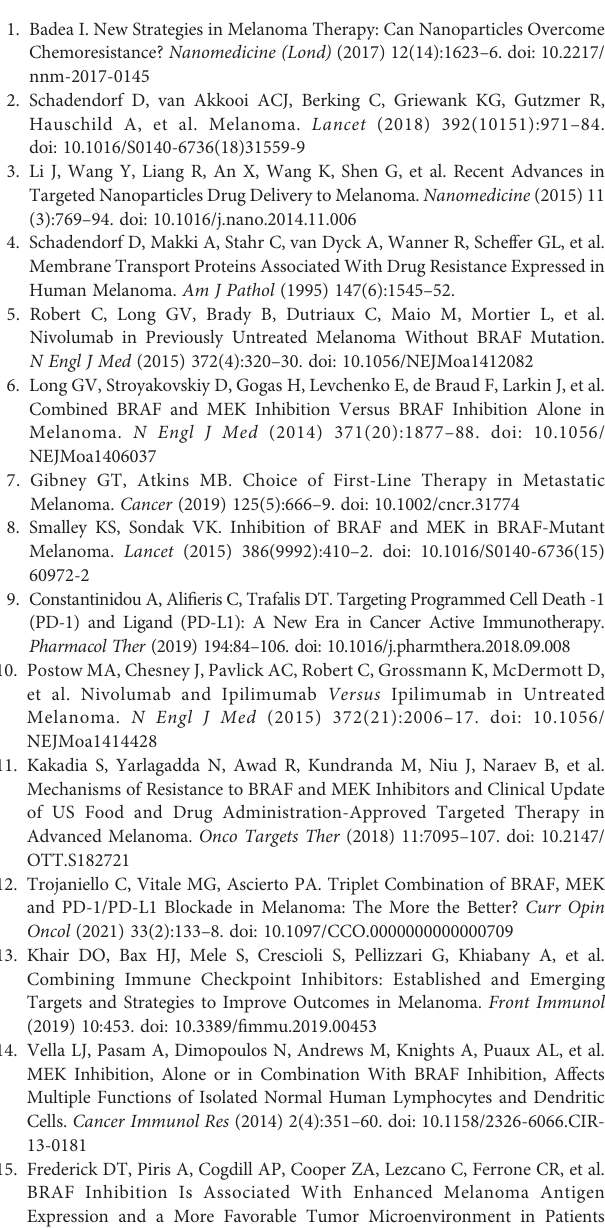
Supplementary Figure 2 | Sensitivity analysis of overall survival (OS). Supplementary Figure 3 | Sensitivity analysis of overall response rate (ORR) Supplementary Figure 4 | Sensitivity analysis of complete response (CR). Supplementary Figure 5 | Sensitivity analysis of partial response (PR). Supplementary Figure 6 | Sensitivity analysis of adverse events for all grades. Supplementary Figure 7 | Sensitivity analysis of adverse events for grade ≥ 3. Supplementary Table 1 | Search